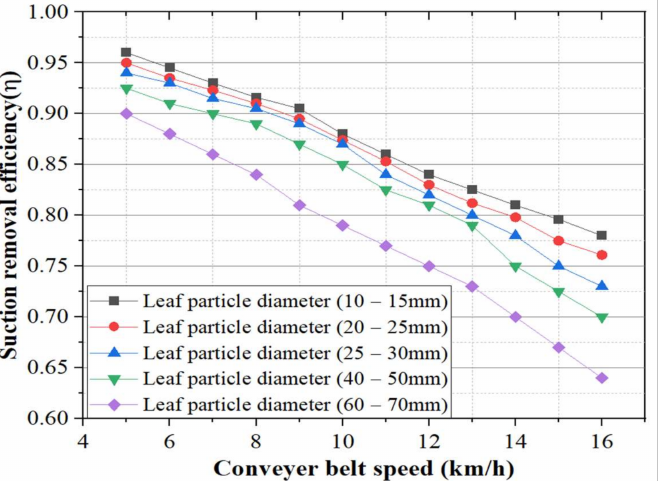
Figure 11. Theresultsofexperimentaleffectsofthediameterofthebladeonthesuctionremoval efficiency.